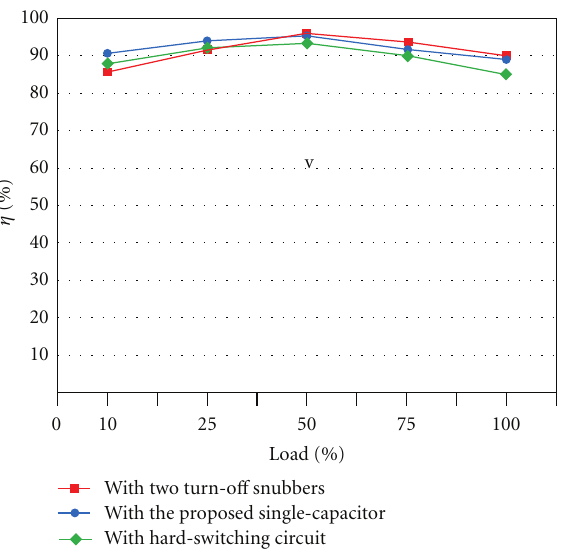
Figure 19: Comparison among e ffi ciencies of the discussed inter- leaving boost converter with a single-capacitor turn-o ff snubber, hard switching, and two sets of turn-o ff snubbers from light load to heavy load.